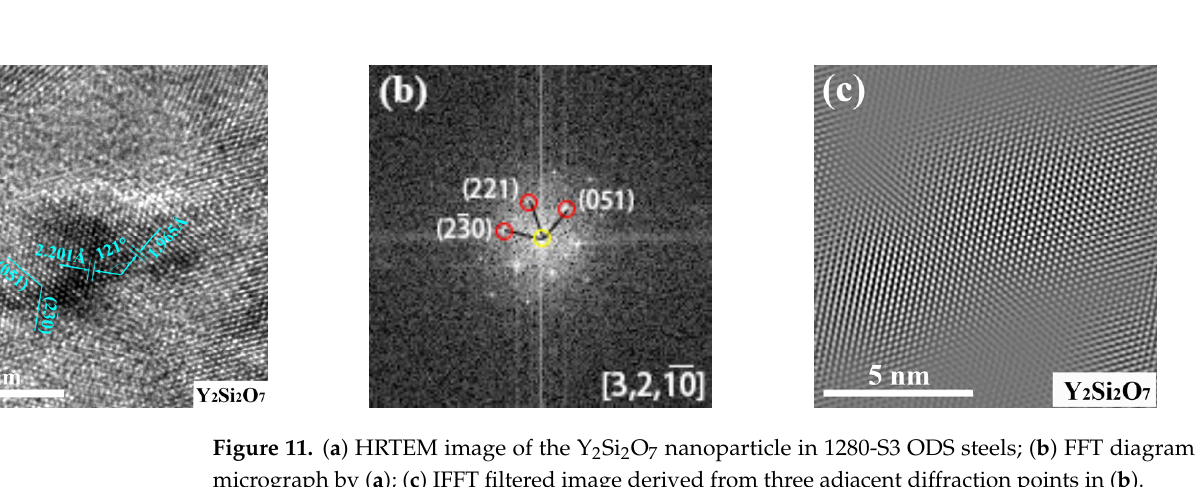
11 of 15 Figure 9. ( a ) High-resolution transmission electron microscopy (HRTEM) image of the Y 2 O 3 nano- particle in 1280-S3 ODS steels; ( b ) FFT diagram micrograph by ( a ); ( c ) IFFT filtered image derived from three adjacent diffraction points in ( b ).